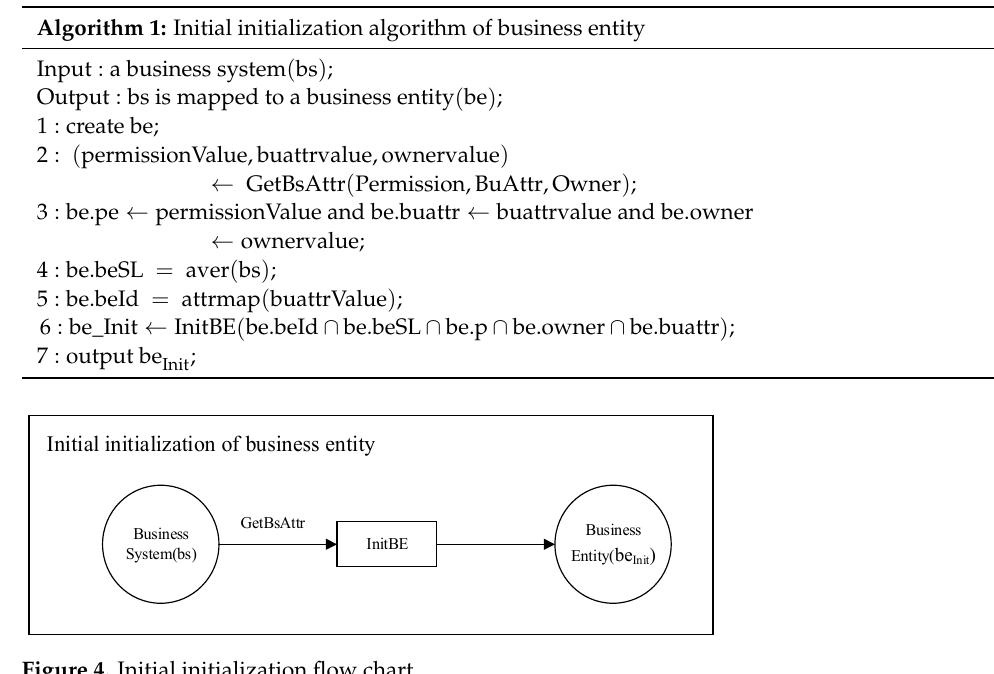
Figure 4. Initial initialization flow chart. Algorithm 1: Initial initialization algorithm of business entity